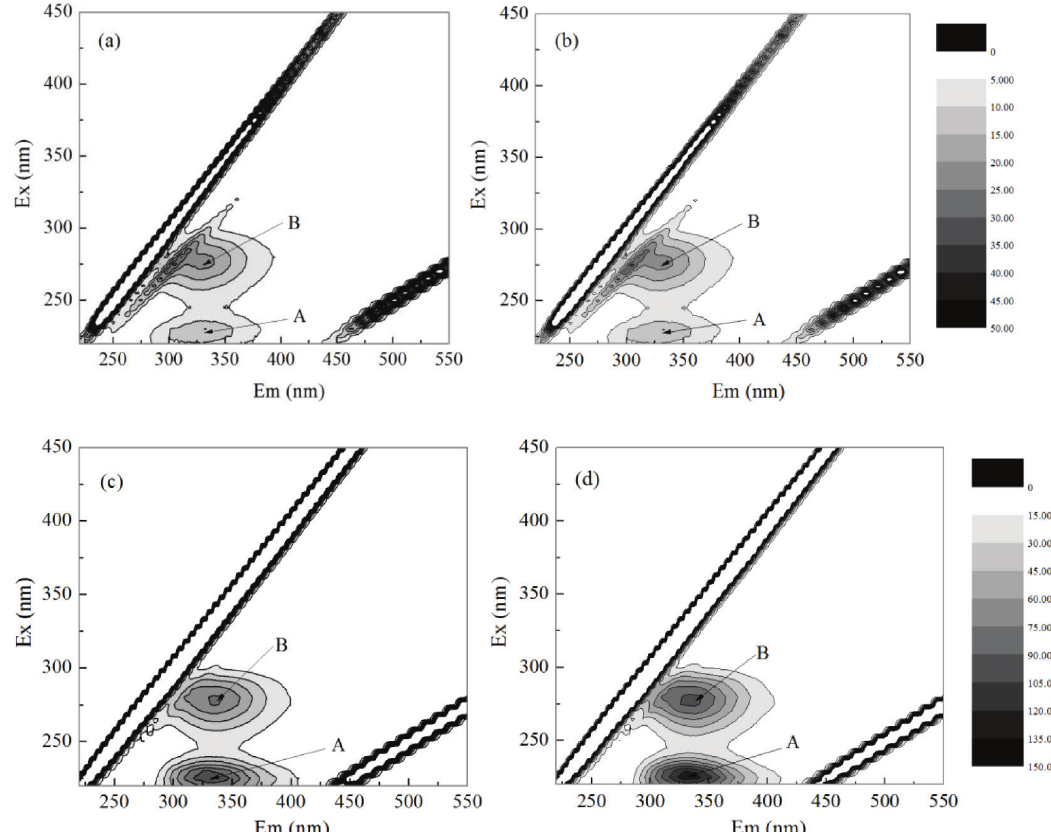
Fig. 4 – 3D-EEM of LB-EPS and TB-EPS in different reactors: (a) LB-EPS of R1, (b) LB-EPS of R2, (c) TB-EPS of R1, (d) TB-EPS of